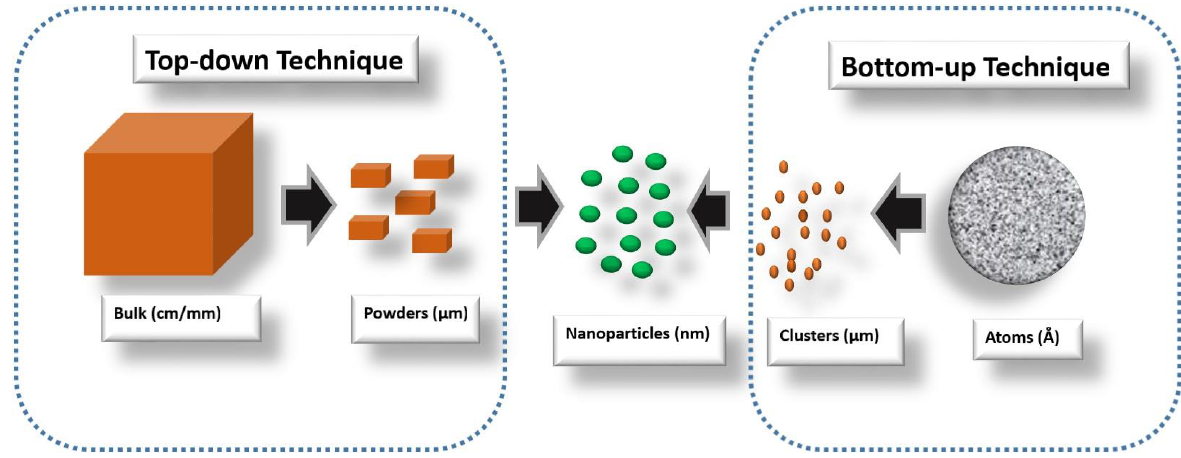
Figure 1. The top-down technique and bottom-up technique.